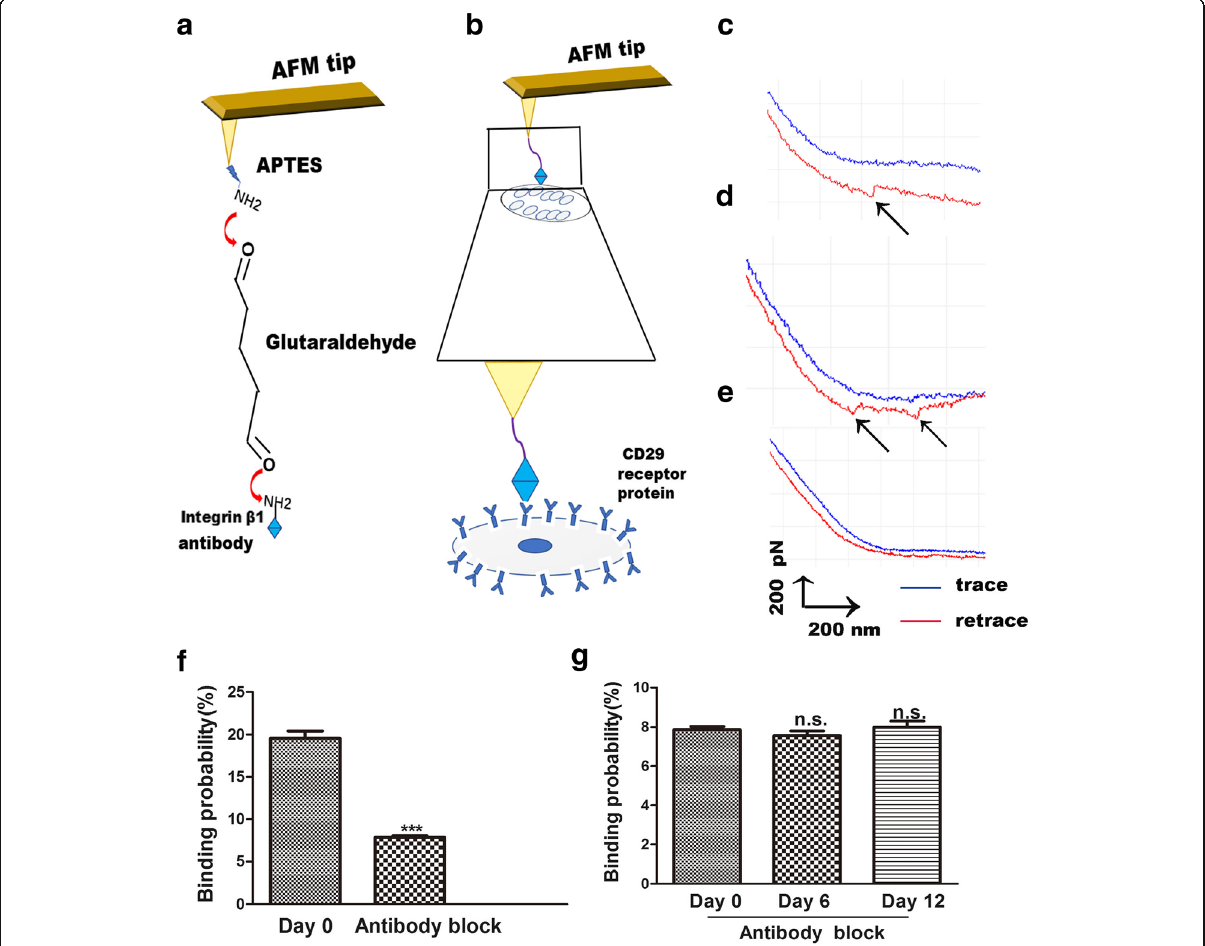
Fig. 4 AFM force measurements with integrin β 1-functionalized AFM tip on living hADSc. a Schematic representation of the strategy used for immobilization of integrin β 1 onto an AFM tip. b Schematic representation of the single-molecule force measured between integrin β 1-functionalized AFM tips and living hADSc. c, d Representative force curves obtained with integrin β 1-modified AFM tips on hADSc, and e after the system was blocked with the integrin β 1 monoclonal antibody solution. f The binding probability of integrin β 1-functionalized tips on hADSc before and after blocking by integrin β 1 antibody on day 0. g The binding probability of CD29-functionalized tips on hADSc after blocking by integrin β 1 antibody at 0, 6, and 12 days. *** p <0.001, n.s.. no significant